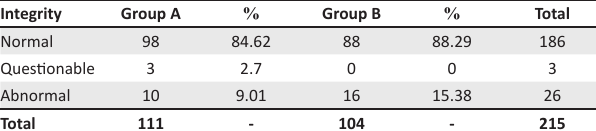
TABLE 4: Ellipsoid zone integrity analysis. TABLE 5: Interdigitation zone integrity